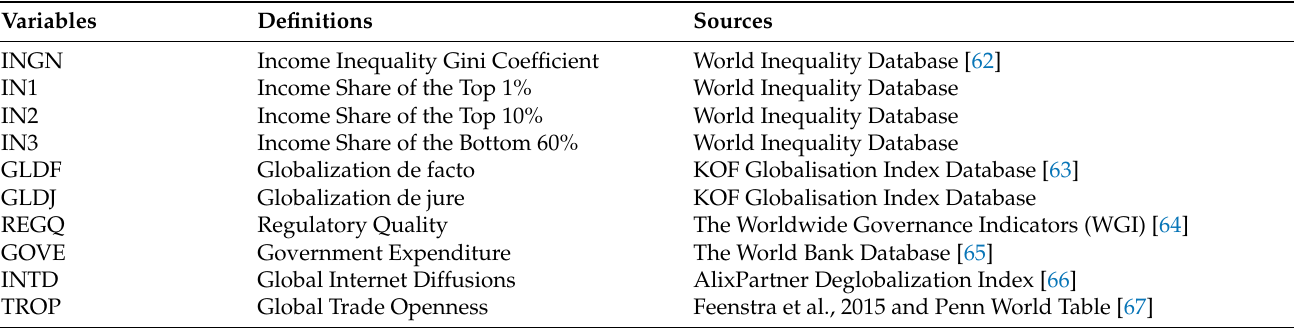
Table 1. Data definitions and